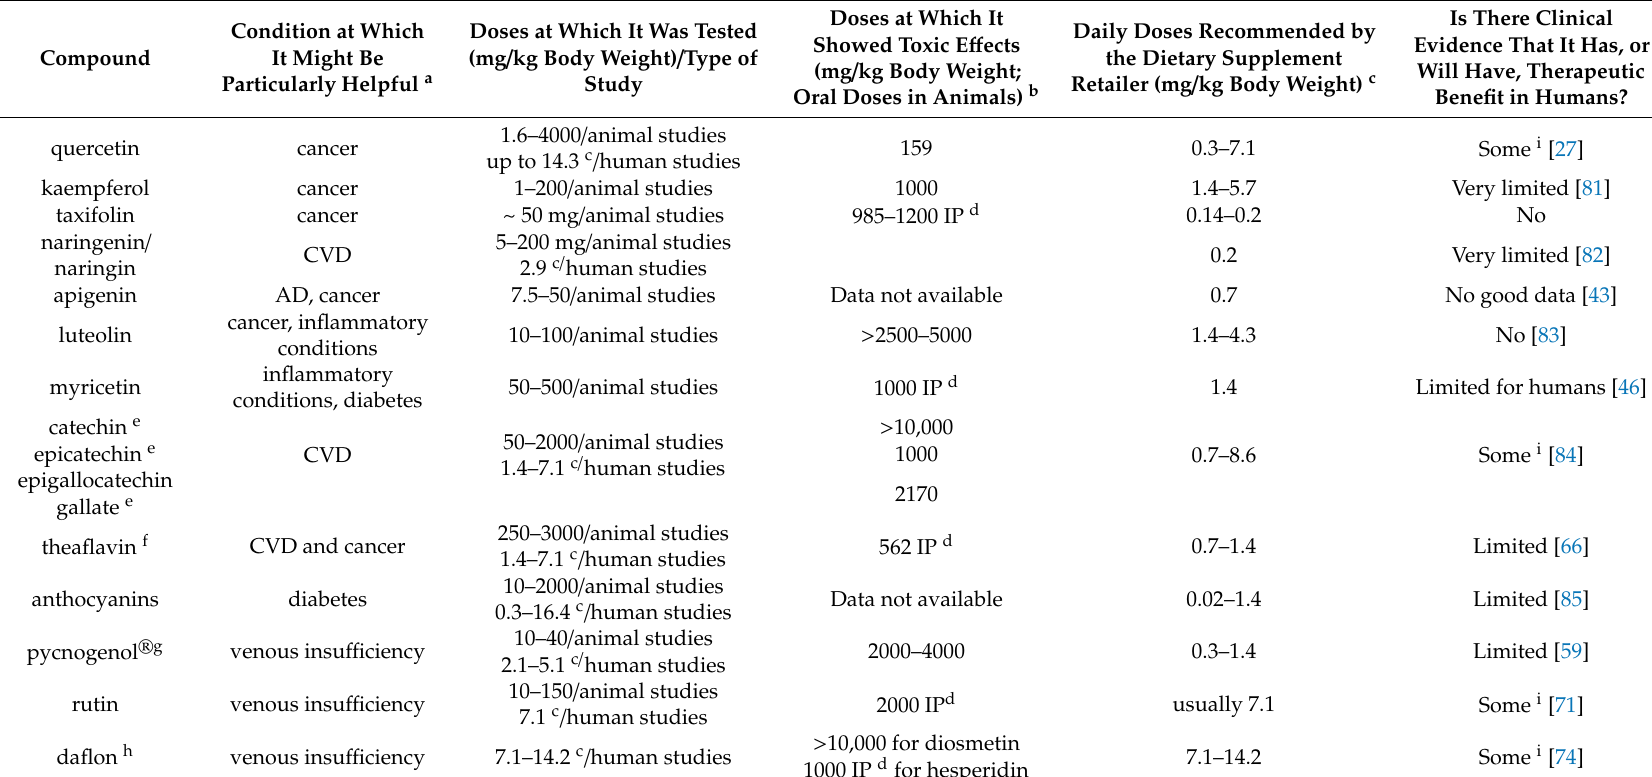
Table 3. How important are flavonoid derivatives in human